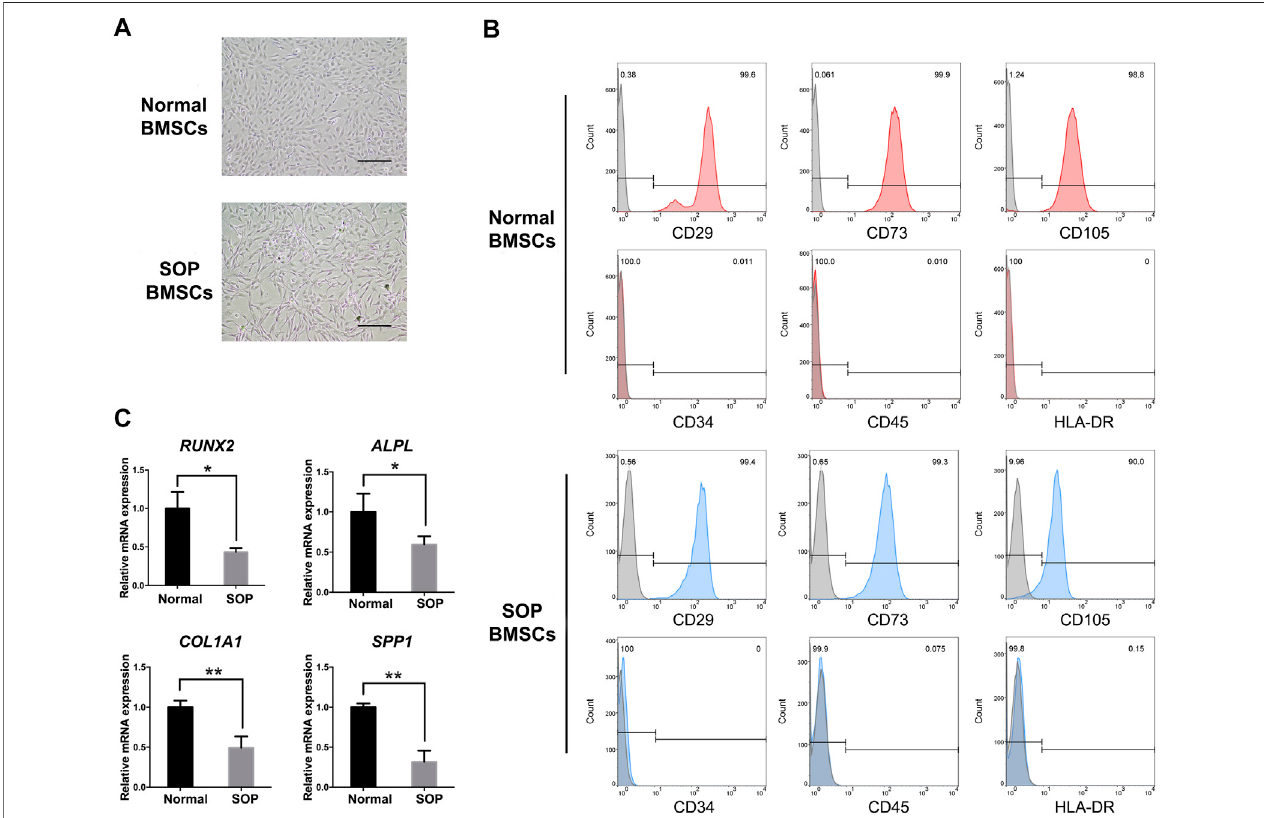
FIGURE 1 | Characterization of hBMSCs from senile osteoporosis patient. (A) The morphology of P2 hBMSCs from normal individuals (Normal BMSCs) and SOP patients (SOP BMSCs); (B) Stem cell surface markers of hBMSCs were analyzed by fl owcytometry. Red (Normal BMSCs) and blue curves (SOP BMSCs) presented positive (CD29, CD73, and CD105) and negative markers (CD34, CD45 and HLA-DR) of hBMSCs, respectively, while grey curves represent isotype controls; (C) Expression of osteogenic genes RUNX2, ALPL, COL1a1 and SPP1 of hBMSCs from SOP patients and control group were measured by qPCR. GAPDH expression was used as an internal control for mRNA expression. Scale bar: 200 μ m. Error bars, SEM (n (cid:1) 3). * p < 0.05, ** p < 0.01.